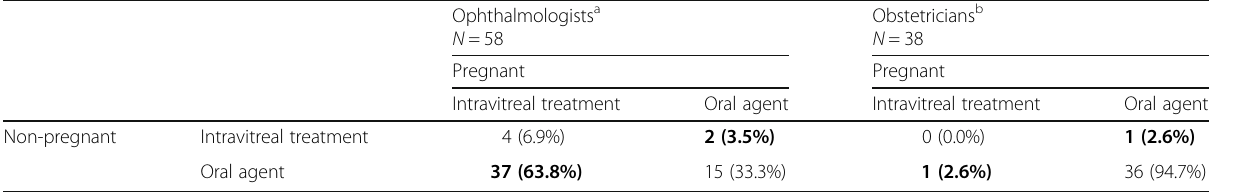
Obstetricians b N = 38